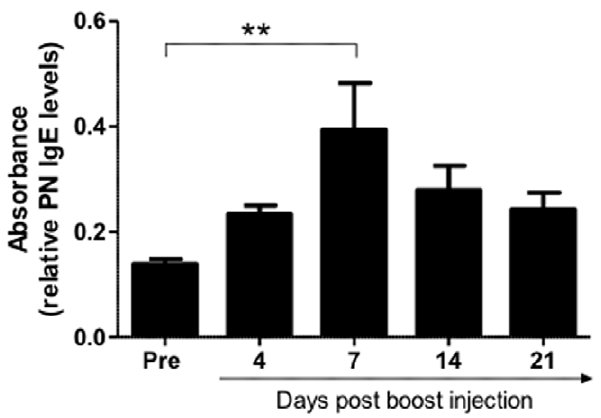
Figure 2. PN-specific IgE responses overtime in allergic sheep. Blood serum samples were collected before sensitisation (pre) and on days 4, 7, 14 and 21 after the final (boost) injection of PN extract, in order to track the peanut specific IgE antibody response overtime. Values are shown as the mean + / 2 SEM, n=5 (data was analysed using a one-way ANOVA on repeated measures, Gaussian approximation); ** indicates a significant difference (p , 0.01) comparing samples collected before and after PN exposure.